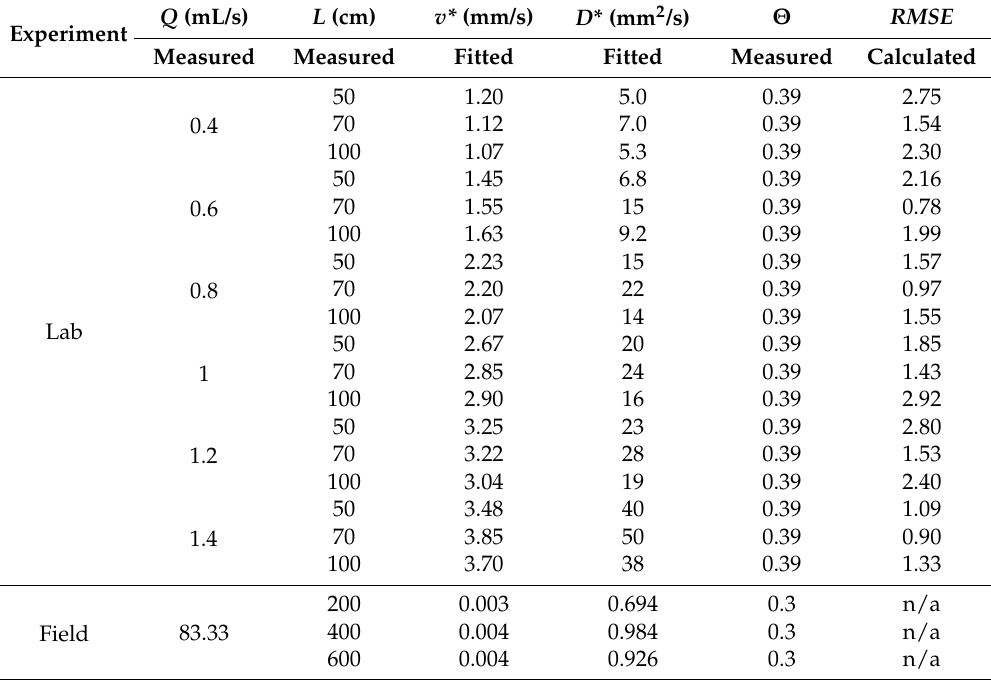
Table 1. Measured and fitted parameters (using the advection–dispersion equation (ADE) model with equilibrium sorption) for Brilliant Blue FCF (BBF) transport through the “lightweight expanded clay aggregate” (Leca) beads at different flow rates and travel distances and field tests. In the legend, Q represents the flow rate; L denotes the travel distance (i.e., the length of the column); v * (= v/R ) is the average flow velocity divided by the retardation coefficient; D * (= D/R ) is the dispersion coefficient divided by the retardation coefficient; θ is the porosity; and RMSE stands for root mean square error between observed values and predicted values.